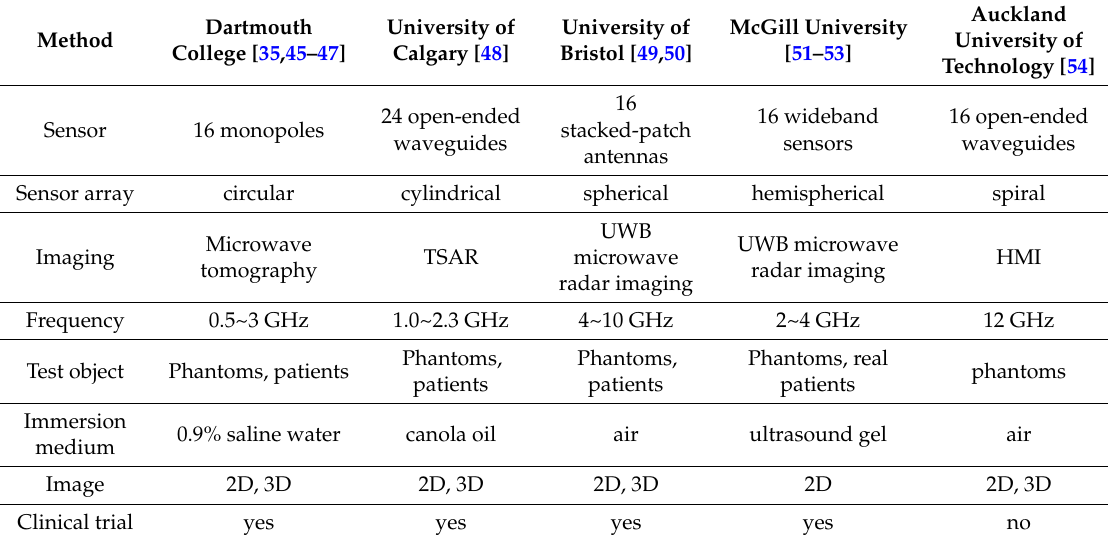
Table 2. Various MI systems for breast cancer